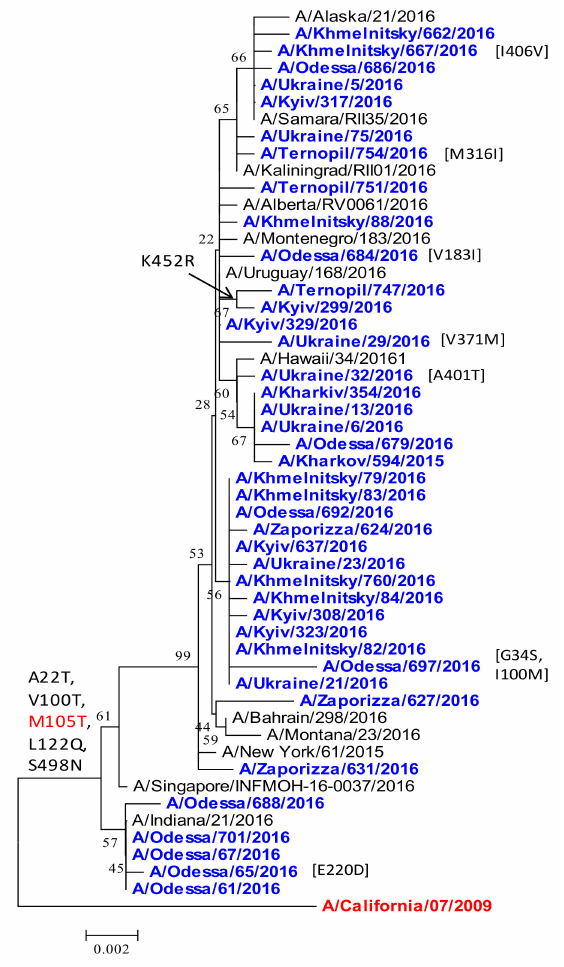
Figure 7. Phylogenetic comparison of A(H1N1)pdm09 influenza virus NP from the 2015/16 season. NP nucleotide sequences were analyzed by NJ method, Kimura 2-parameter model, with 1000 boot- strap replications. Ukrainian clades are colored blue; reference strains are black, except the vaccine strain (red/bold); amino acid variations are indicated, with M195T common in all isolates